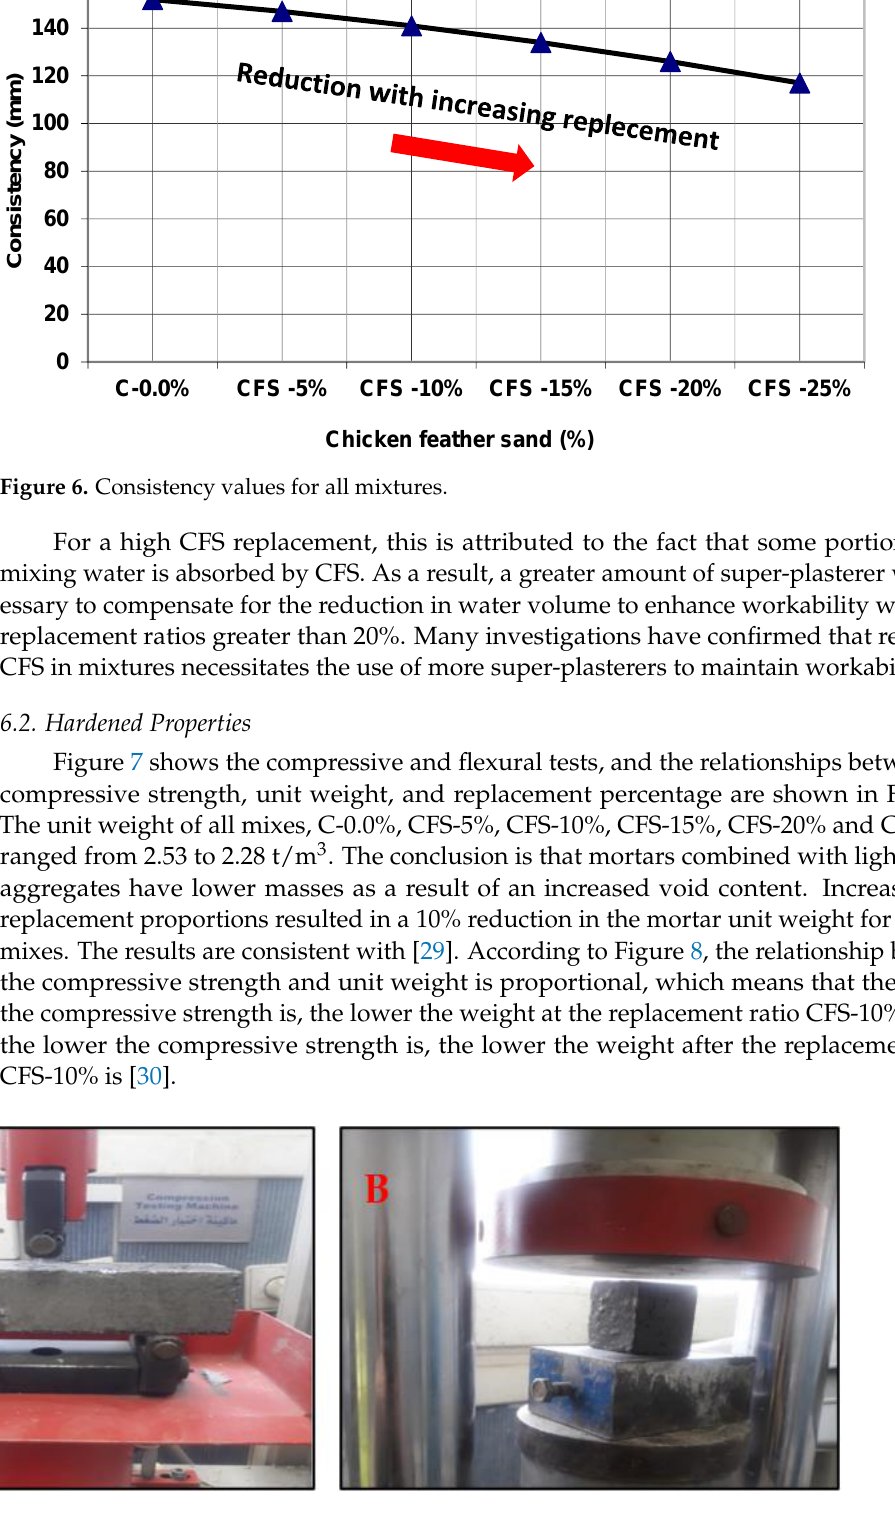
8 of 17 Table 4. Properties of the CFS mortar. Sample